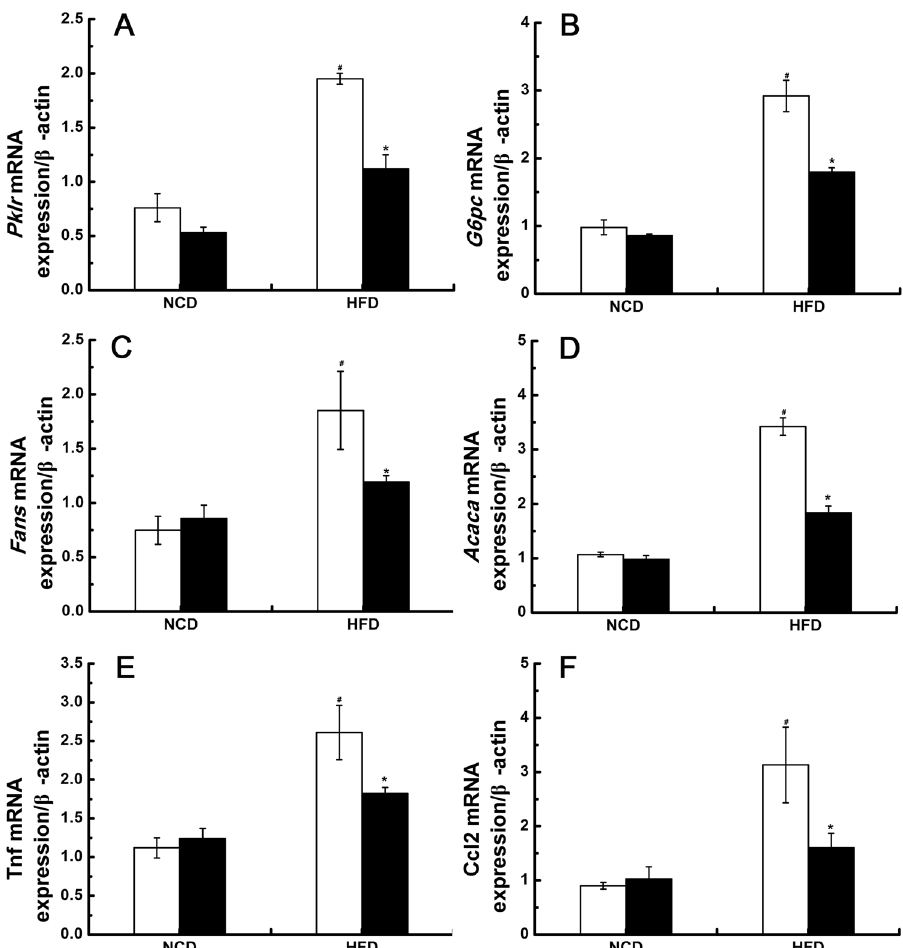
Figure 4. Down-regulation of Tlr4 mRNA expression in the hypothalamic ARC improves the metabolic parameters and inflammation in liver. ( A and B ) the changes of glucose metabolism genes ( Pklr and G6pc ) expression. ( C and D ) the changes of lipid metabolism genes ( Fans and Acaca ) expression. ( E and F ) the changes of inflammatory markers ( Tnf- α and Ccl2 ) expression. The white bar represents scrambled shRNA treated group, and the black bar represents Tlr4 shRNA treated group. Pklr: pyruvate kinase; G6pc: glucose-6-phosphatase; Fasn: fatty acid synthase; Acaca: acetyl CoA carboxylase, NCD: normal chow diet group; HFD: high fat diet group; n = 7–8 per group. The results are shown as the mean ± S.E.M. # P < 0.05 for HFD group compared with NCD group; * P < 0.05 for Tlr4 shRNA treated group compared with scrambled shRNA treated